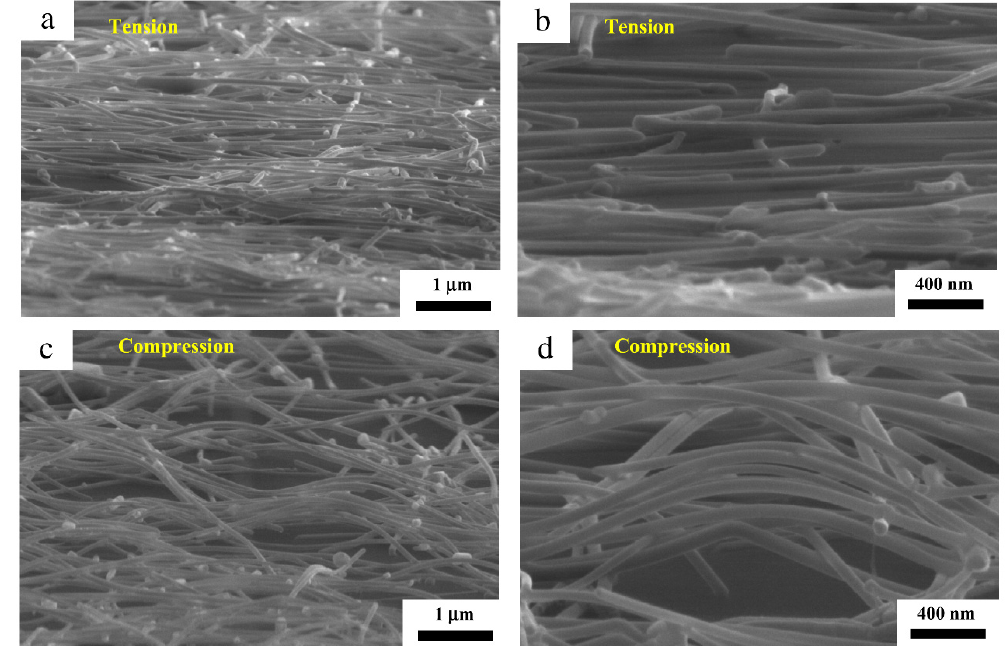
Figure 11. SEM images of silver nanowire networks under tensile stress in ( a ) low and ( b ) high magnification, and compressive stress in ( c ) low and ( d ) high magnification. The strain value was 2.5% for both samples. Reproduced with permission from ref. [43]. Copyright 2016, Elsevier.